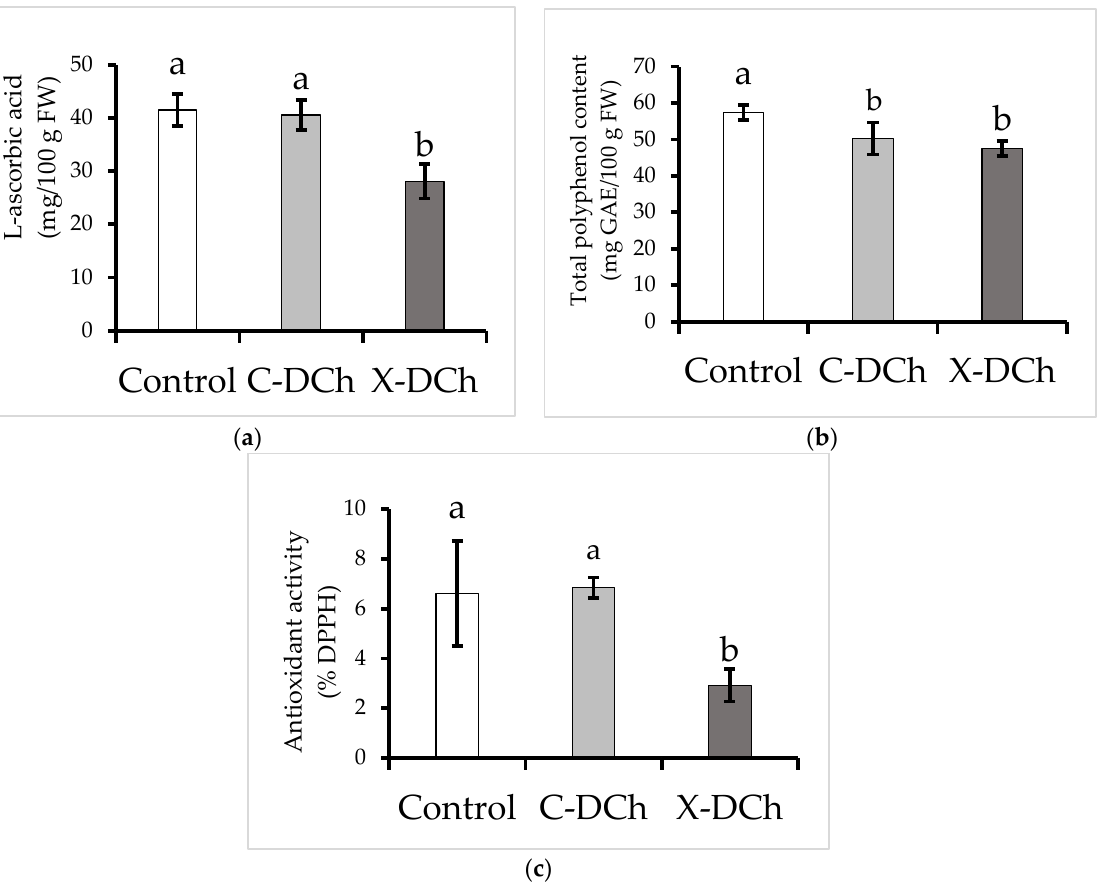
Figure 2. L-ascorbic acid ( a ) and total polyphenol content ( b ) and antioxidant activity (DPPH) ( c ) of pineapple lily treated with carrageenan-depolymerized chitosan (C-DCh) and xanthan-depolymerized chitosan (X-DCh). Data are presented as means ( ± SD) and bars with different letters in each graph are significantly different by Duncan’s Multiple Range Test (DMRT) at α ≤